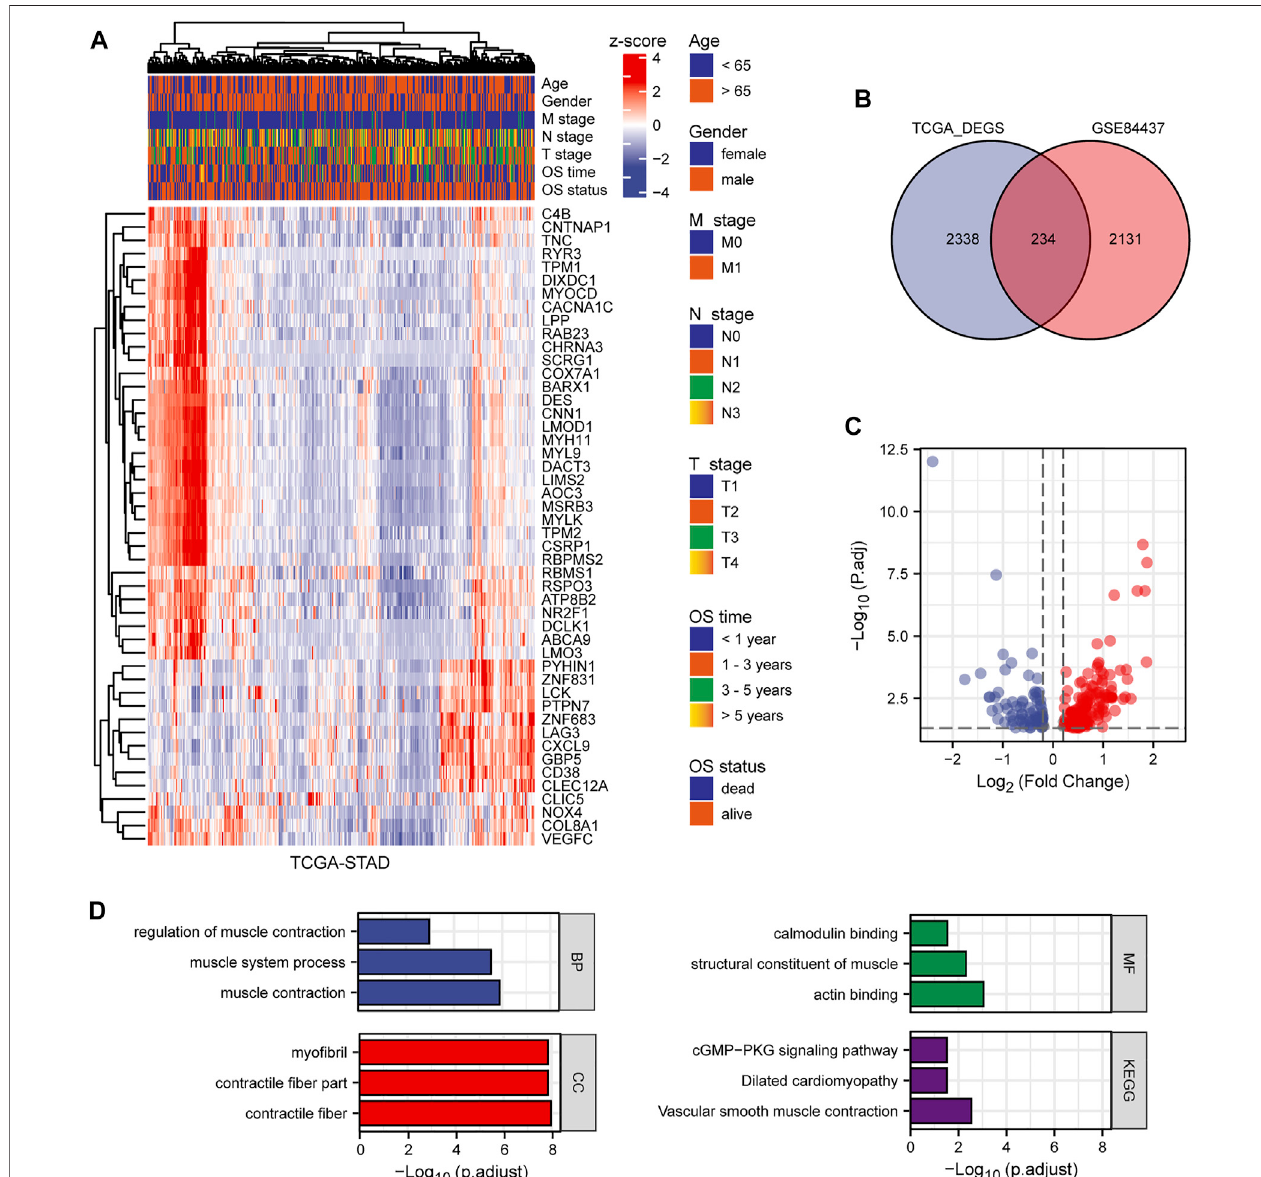
FIGURE 2 | The results of differential expression analysis. (A) Heat map of the top 50 differentially expressed genes. (B) Venn diagram showing the intersection of TCGA-STAD and GSE84437. (C) Volcano plot showing the results of differentially expressed genes. (D) GO and KEGG enrichment of differentially expressed genes.